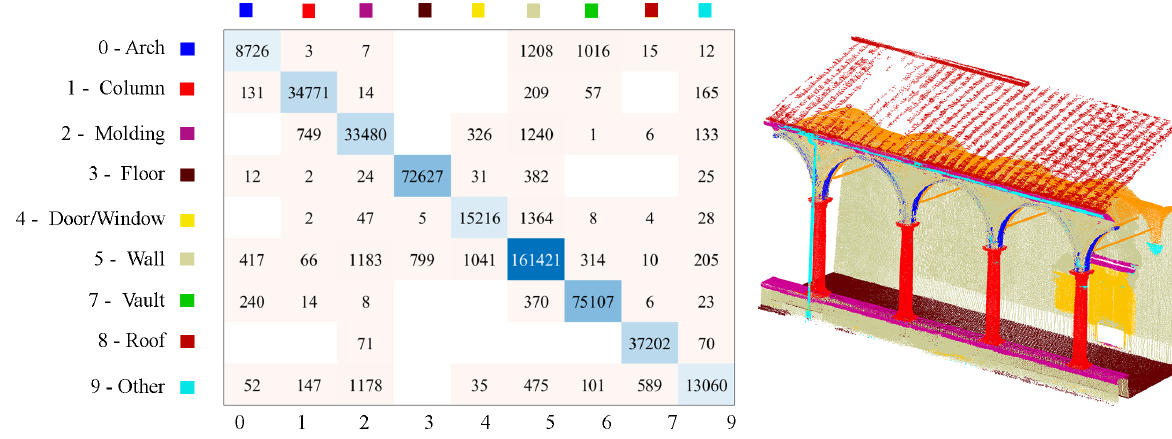
Figure 5. Confusion matrix for the Grand cloister dataset with related holdout validation set.